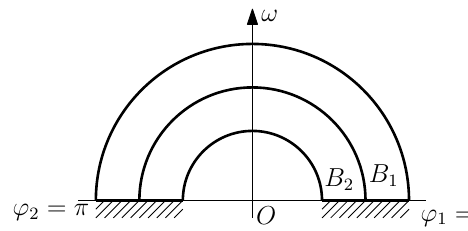
Figure 8: Plot of N ( φ ) (Example 5.1).